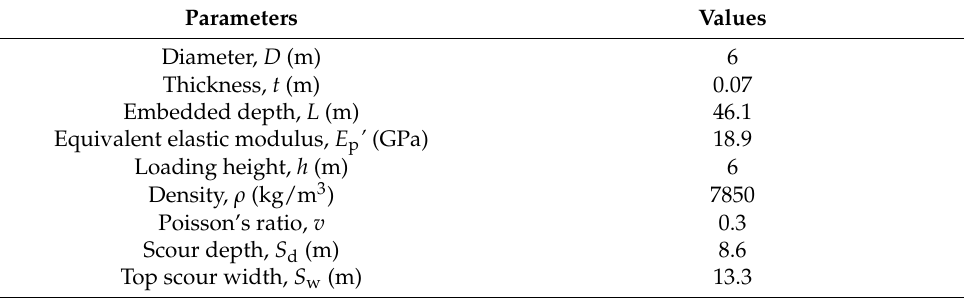
Table 8. Parameters of the soil in Zhugensha sea area.